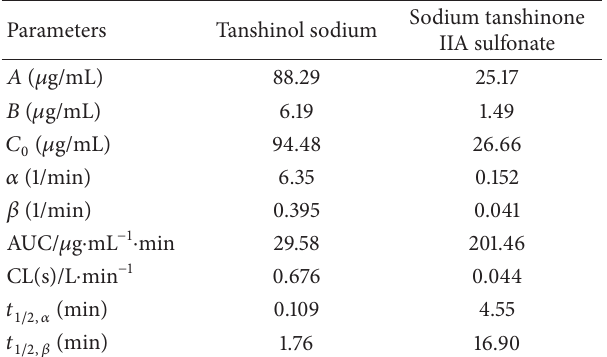
Table 7: Pharmacokinetics parameters of tanshinol sodium and sodium tanshinone IIA